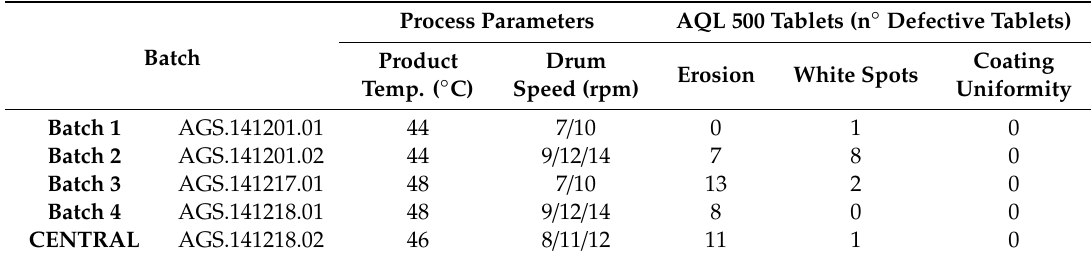
Table 4. Visual inspection results (acceptance quality limit (AQL)) per